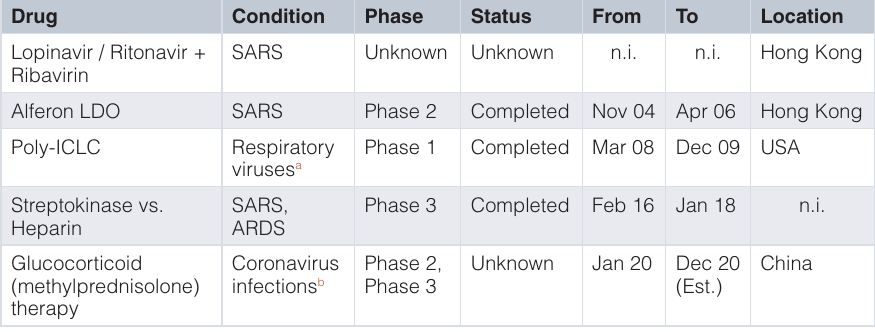
Table 5. Drugs targeting SARS that are registered for the U.S. Food and Drug Administration (USFDA) clinical trials (as of mid-February 2020). ‘n.i.’ = no